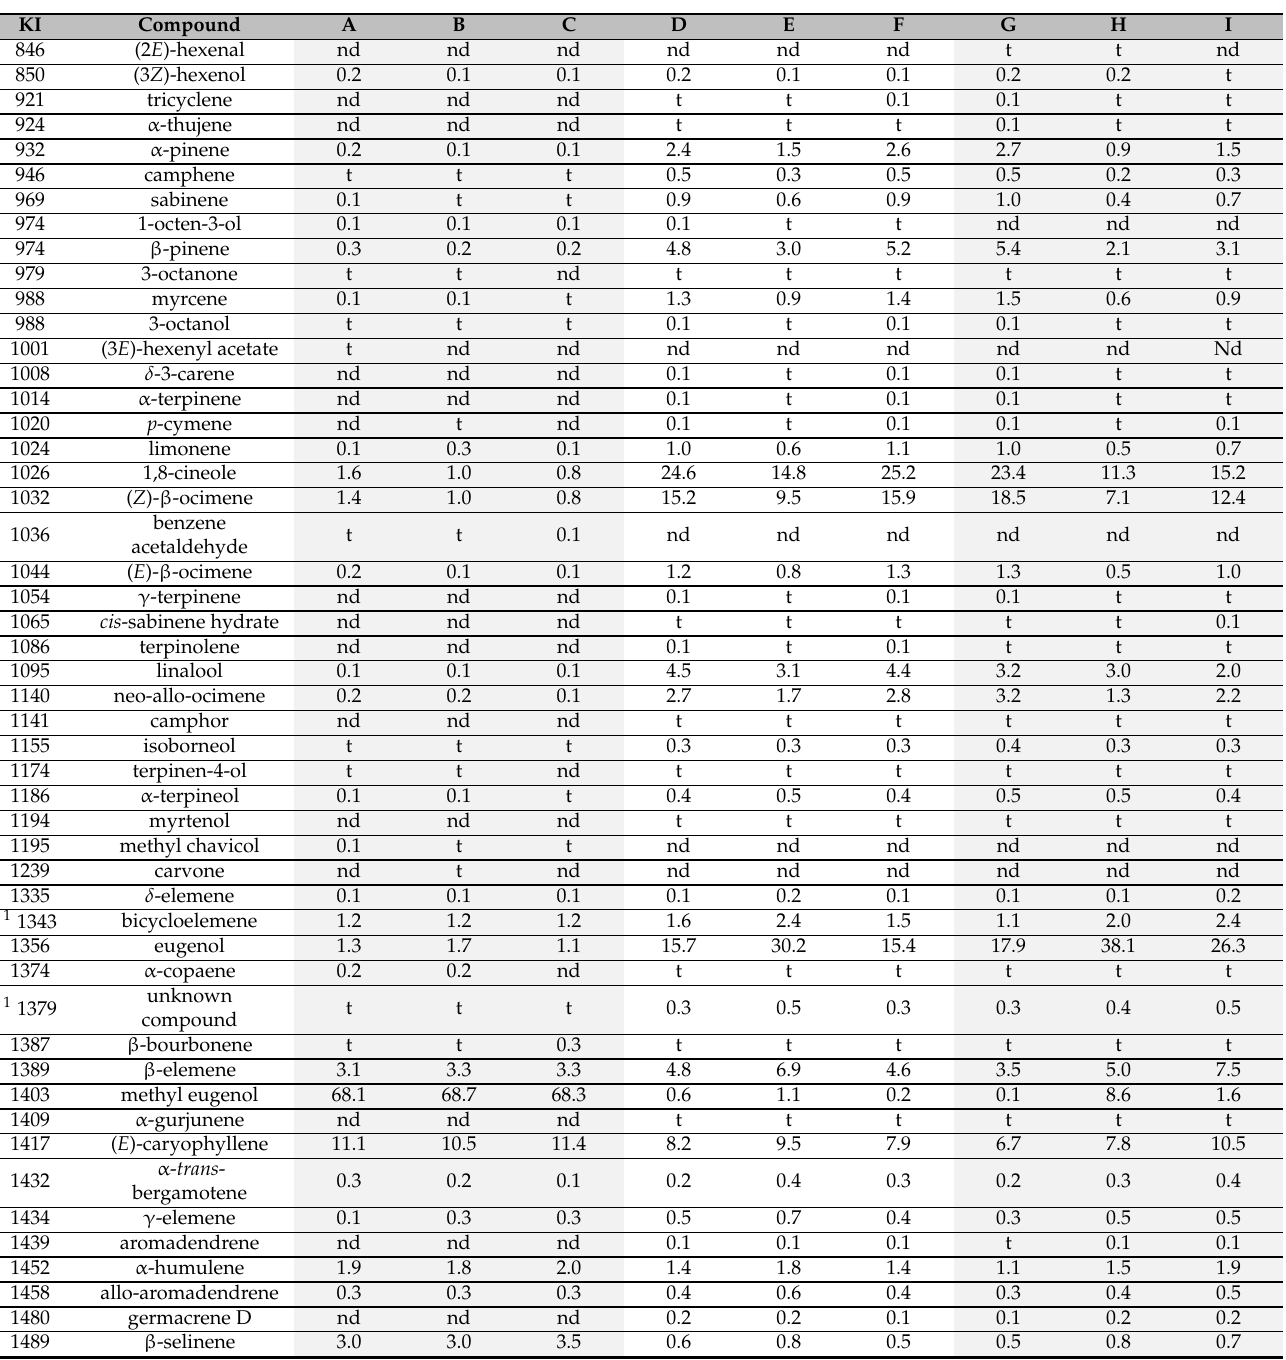
Table 1. Ocimum campechianum essential oil profiles ( n = 9) from Pueblo Libre (A–C), El Diamante (D–F), and Villa Rica (G–I). The Kovat’s Index (KI), volatile compound name, and compound average area % for each sample are provided. Each essential oil sample was analyzed in triplicate to ensure repeatability (standard deviation < 1 for all values). Values less than 0.1% are denoted as trace (t) and those not detected in that sample as not detectable (nd). The KI values were previously calculated by Robert Adams using a linear calculation on a DB-5 column